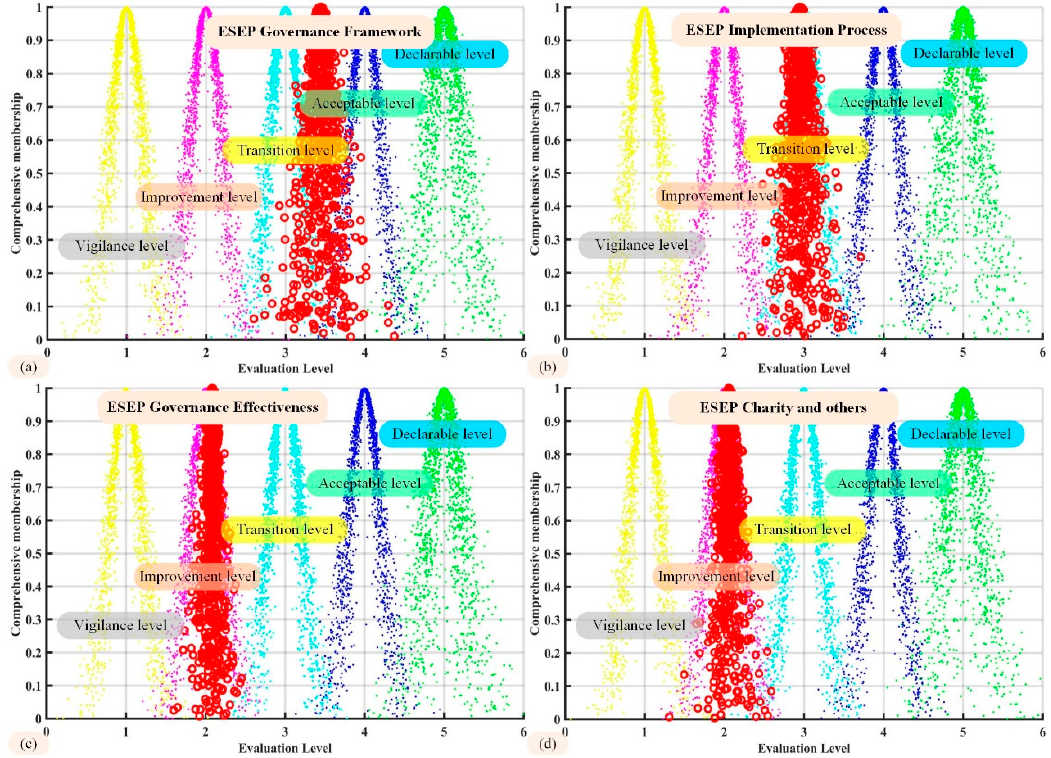
Figure 7. Evaluation cloud chart. ( a ) ESEP governance framework; ( b ) ESEP implementation process; ( c ) ESEP governance effectiveness; ( d ) ESEP charity and others.